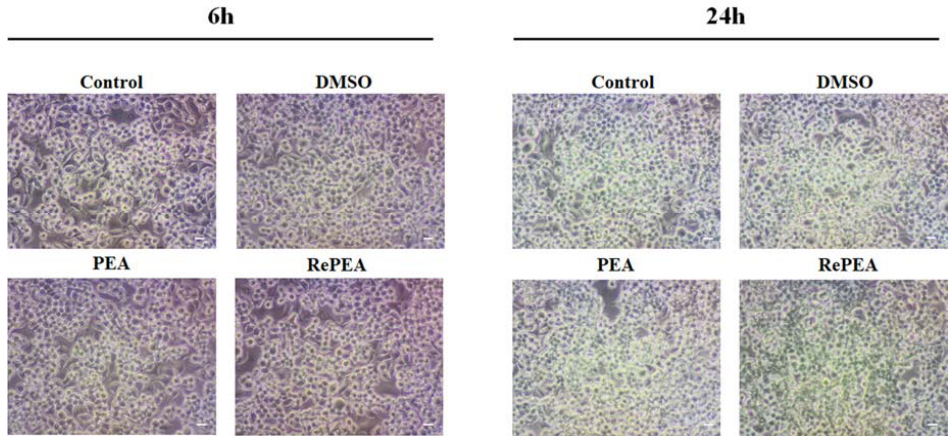
Figure 9. Cellular morphology of N9 cells incubated for 1 h with 100 nM PEA or RePEA. Then,